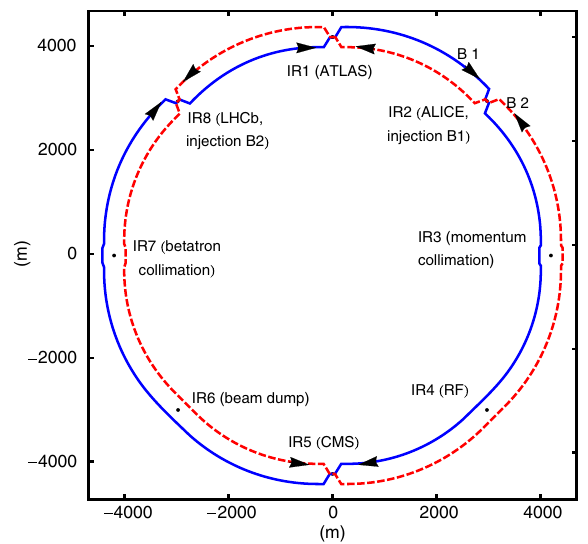
FIG. 2. The schematic layout of the LHC (the separation of the two rings is exaggerated). The two beams are brought into collision at the four experiments ATLAS, ALICE, CMS, and LHCb. Adapted from Ref.